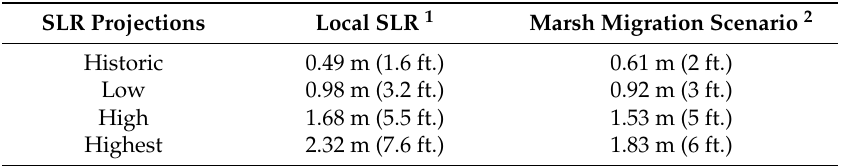
Table 2. Local sea level rise (SLR) projections at the end of the century for the Chesapeake Bay Regions and the nearest marsh migration